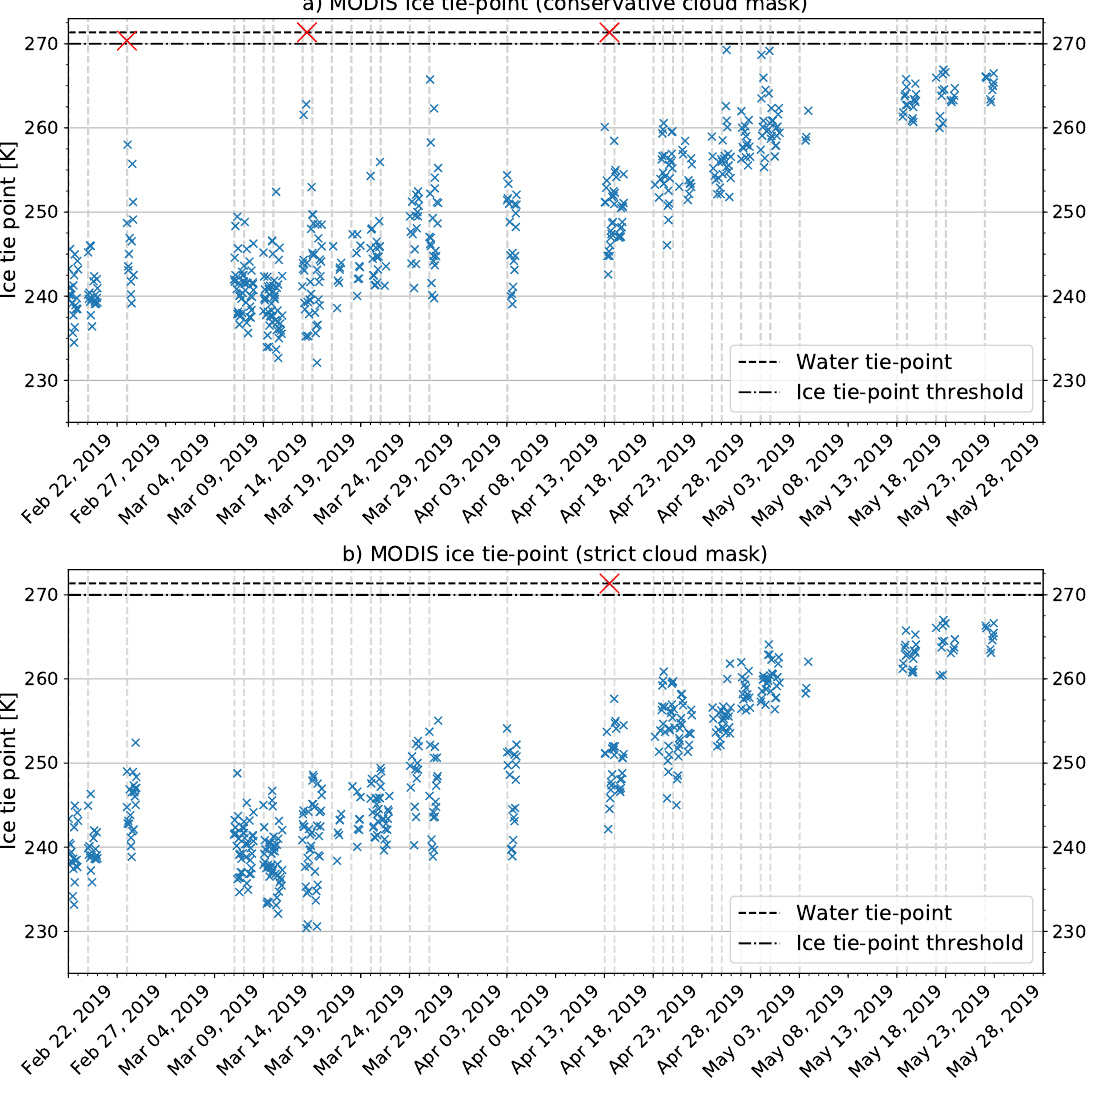
Figure 3. Time-series of the ice tie-point when applying the conservative cloud mask (panel ( a )) and the strict cloud mask (panel ( b )). The x-axis shows the date; the vertical lines mark the days with Sentinel-2 scenes. The dashed horizontal line shows the water tie-point. The dash-dotted line gives the threshold above which no SIC is retrieved in the current version of our retrieval. Red crosses mark the granules above the